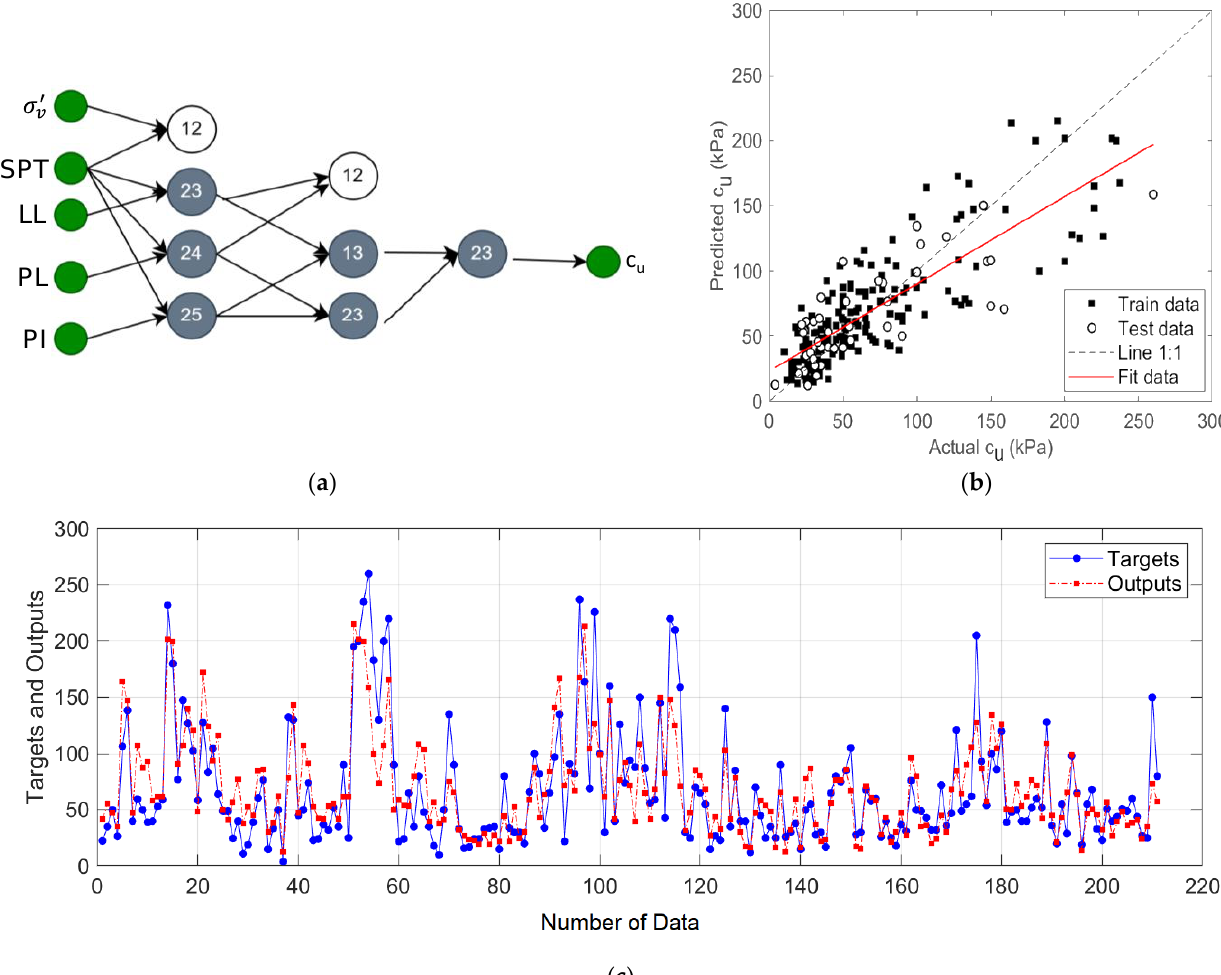
Figure 8. The proposed prediction model for input variables σ v ’ , N SPT , LL, PL , and PI : ( a ) three-layer GMDH-type NN structure; ( b ) regression plot; ( c ) target and output predictive values.